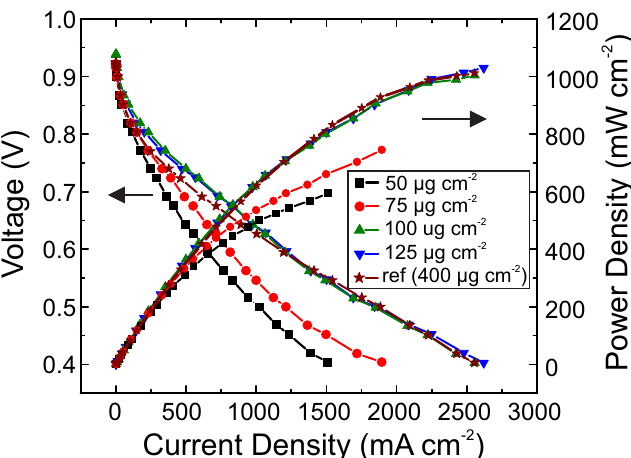
Figure 4. J-V and power density curves of PEM fuel cells having the cathode deposited by PLD with various Pt loadings. The performance of a PEM fuel cell using E-TEK Pt/C for the cathode with a Pt loading of 400 µ g · cm − 2 is shown for comparison. All data were measured at an outlet pressure of 100 kPa. Table 1. Performance of PEM fuel cells using cathode catalyst prepared by PLD with various